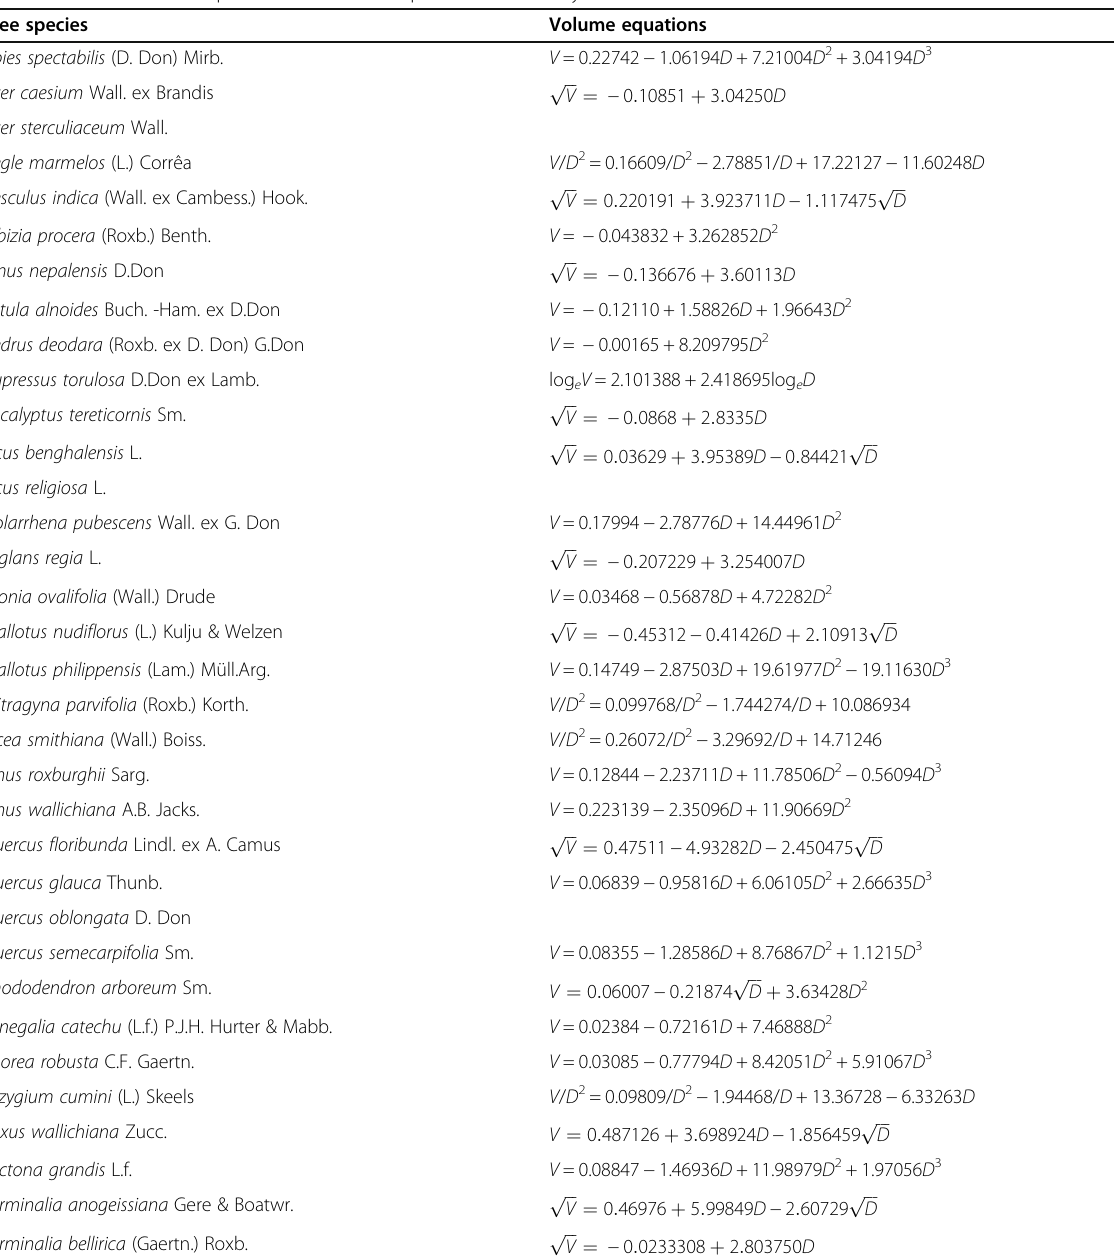
Table 2 List of volume equations for the tree species in the study sites Tree